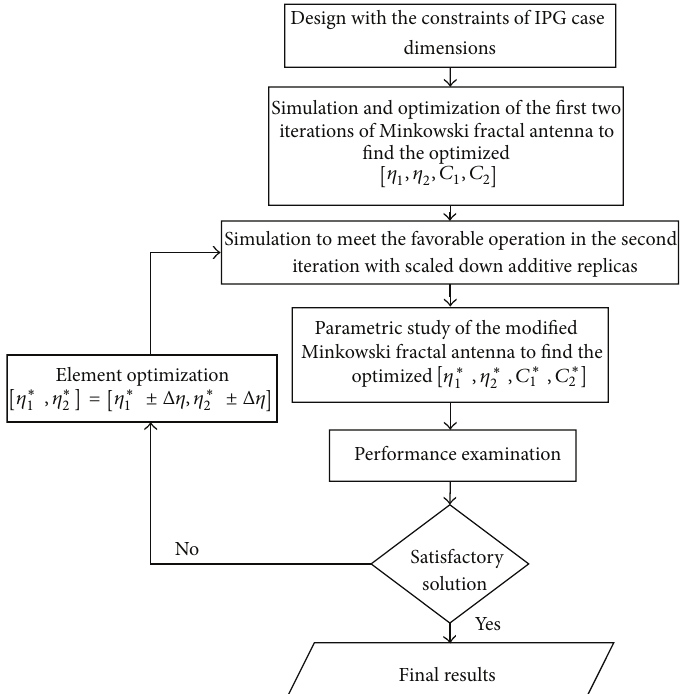
Figure 4: The flowchart of designing and parameter optimization process of the proposed modified Minkowski fractal